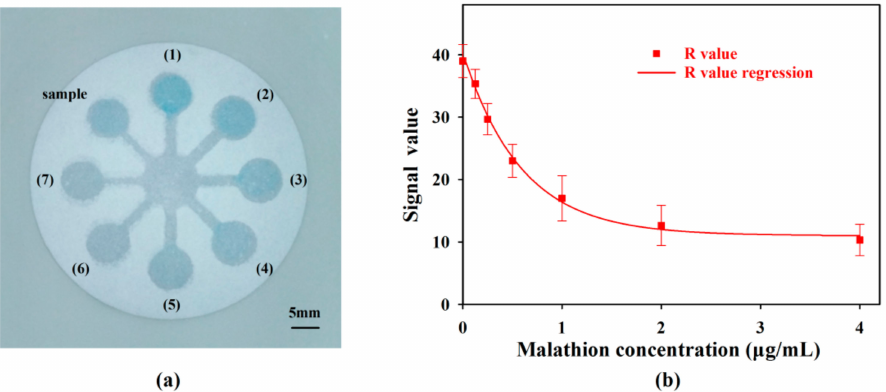
Figure 10. ( a ) Assay for malathion conducted on the traditional µ PAD fabricated by plasma treatment. ( b ) Signal values for different levels of malathion concentration on the traditional µ PAD.